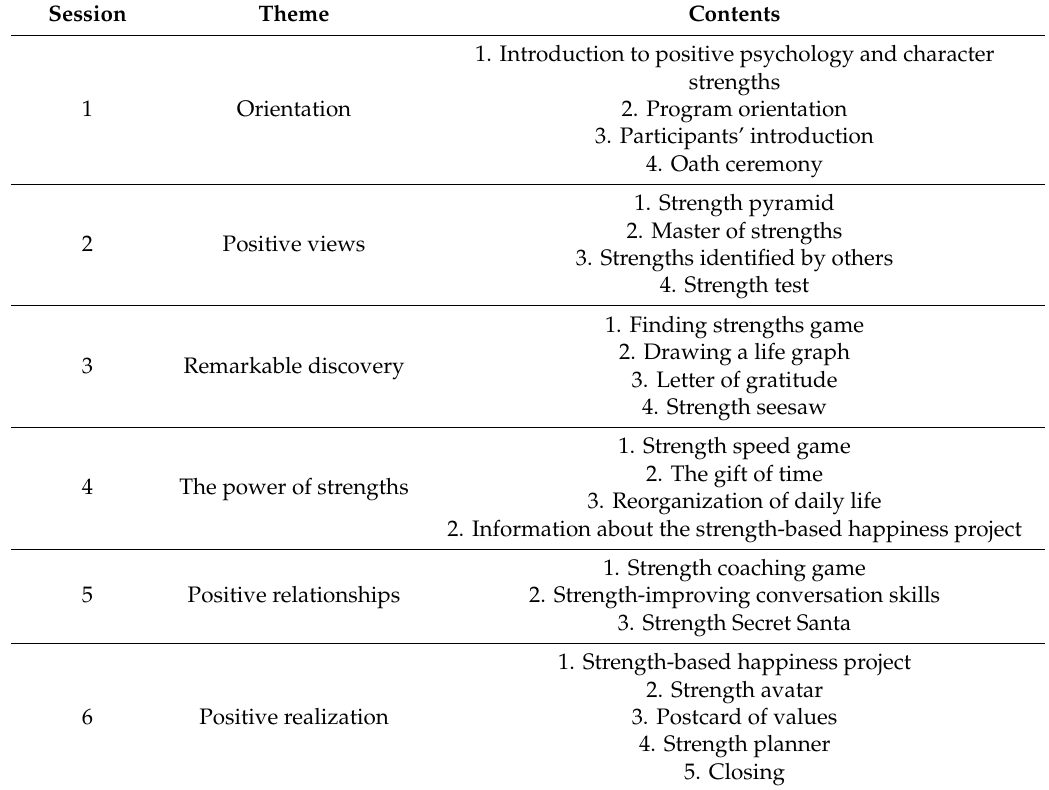
Table 1. Character strength exploration program for nursing